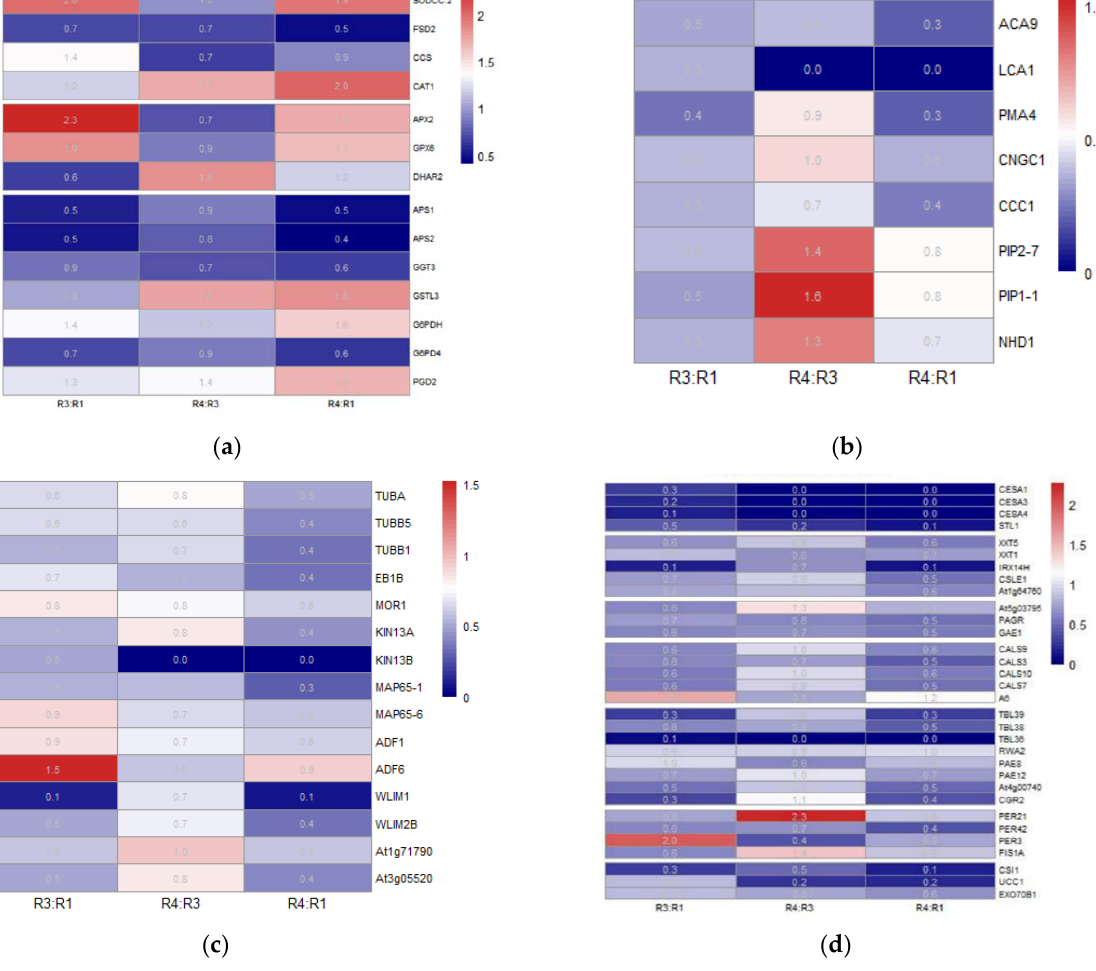
Figure 9. Crosstalk between ABA and CK signaling pathways. The left half of the protein (cube) represents R3/R1, and the right half represents R4/R3. Blue represents significantly down-regulated (<0.67), red represents significantly up-regulated (>1.5), and gray represents unidentified or non- DEPs. The predicted content changes of CK and ABA are marked by triangles. 4. Discussion 4.1. Plant Hormones The response modes of plant hormones to abiotic stress are closely related to their regulation functions upon growth and development. Abscisic acid (ABA) is regarded as a “stress hormone” due to its extensive association with plant adaptation to various stresses [15]. Its accumulation under drought or salt stress induces stomatal closure and growth